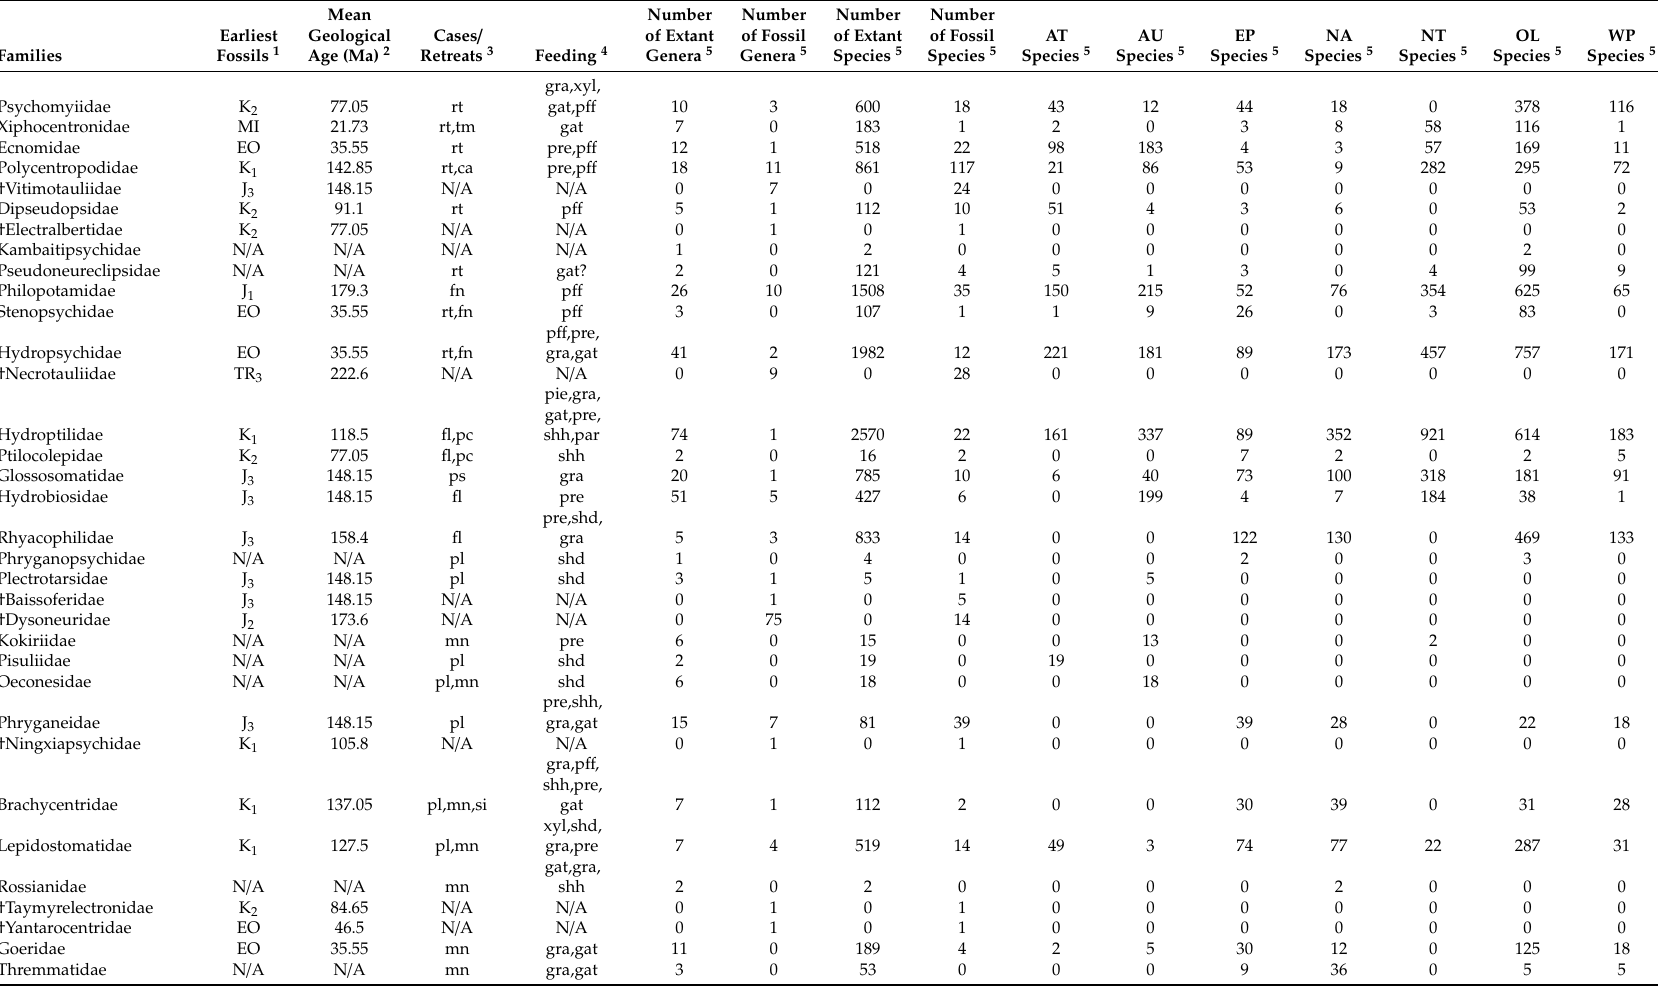
Table 1. Extant and fossil ( † ) families of Trichoptera, each with earliest fossil epochs, mean geological age, larval cases or retreats, feeding types, numbers of extant and extinct genera and species of the world, and numbers of extant species in seven biogeographic